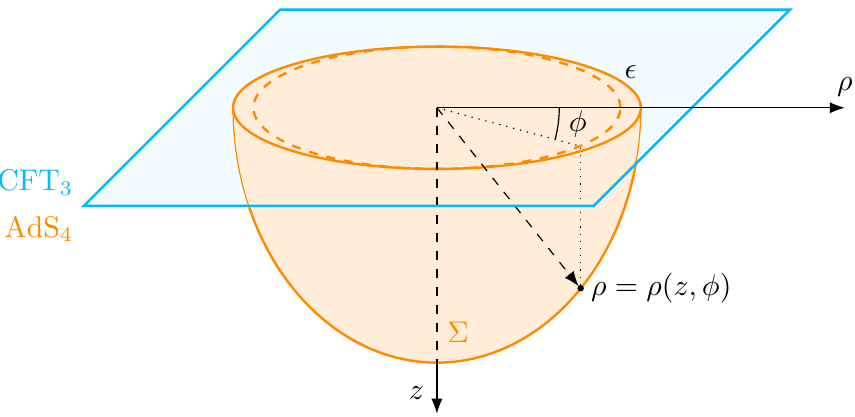
Figure 1 . Time slice of minimal co-dimension two surface (cid:6) with an elliptical deformation (cid:15) ( ‘ =